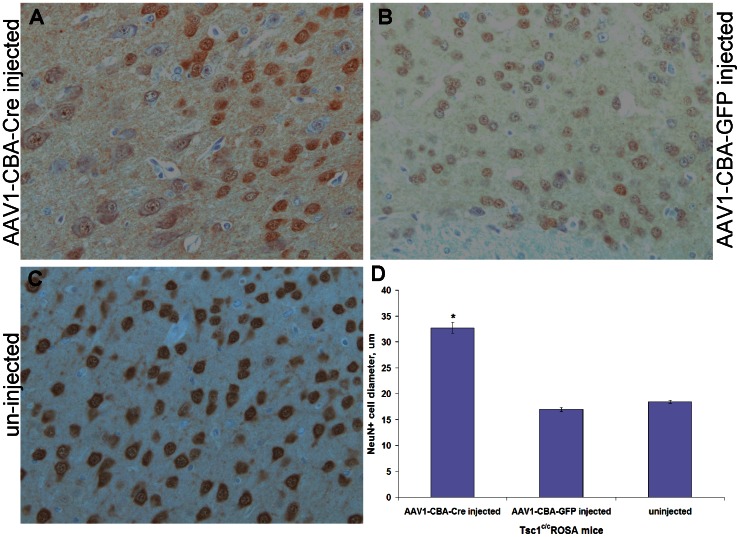
NeuN staining for neuronal diameter measurements.Immunostaining for NeuN (counterstained with haematoxylin) shows that neurons above the lateral ventricles in (A) AAV1-CBA-Cre injected Tsc1c/c mice were considerably larger than those in controls in the same region: (B) AAV1-CBA-GFP injected and (C) uninjected mice. Magnification = 40X. (D) Periventricular neurons in the brains of AAV1-Cre and AAV1-GFP injected, as well as non-injected mice (P30) were stained for the neuronal marker, NeuN and the widest diameter of stained cell bodies was measured in >30 randomly selected cells from several fields with 3 animals per group. Neurons in the AAV1-CBA-Cre injected brains had an almost 2-fold increase in diameter, as compared to controls, shown as mean±SEM (*p<0.0001).